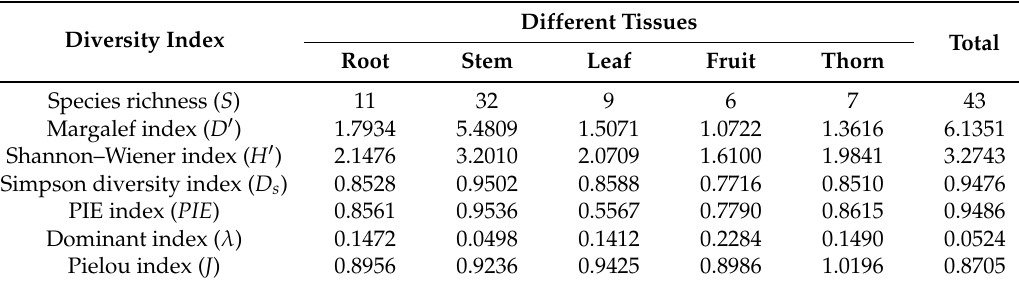
Table 4. Diversity analyses of endophytic fungi from Z. bungeanum